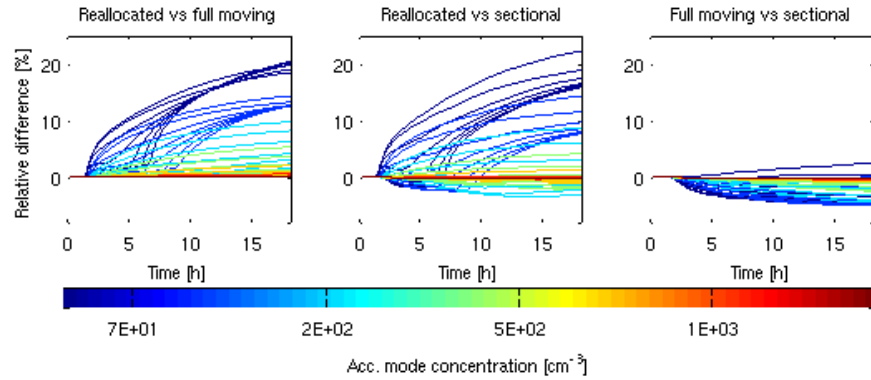
Figure 15: The relative difference of a extinction coefficient between the three models. Fig. 15. The relative difference of a extinction coefficient between the three